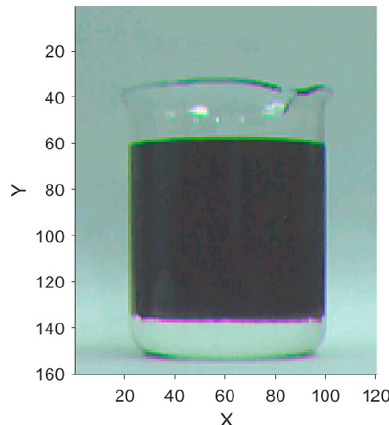
Figure 2. RGB image of the crude oil to be tested.